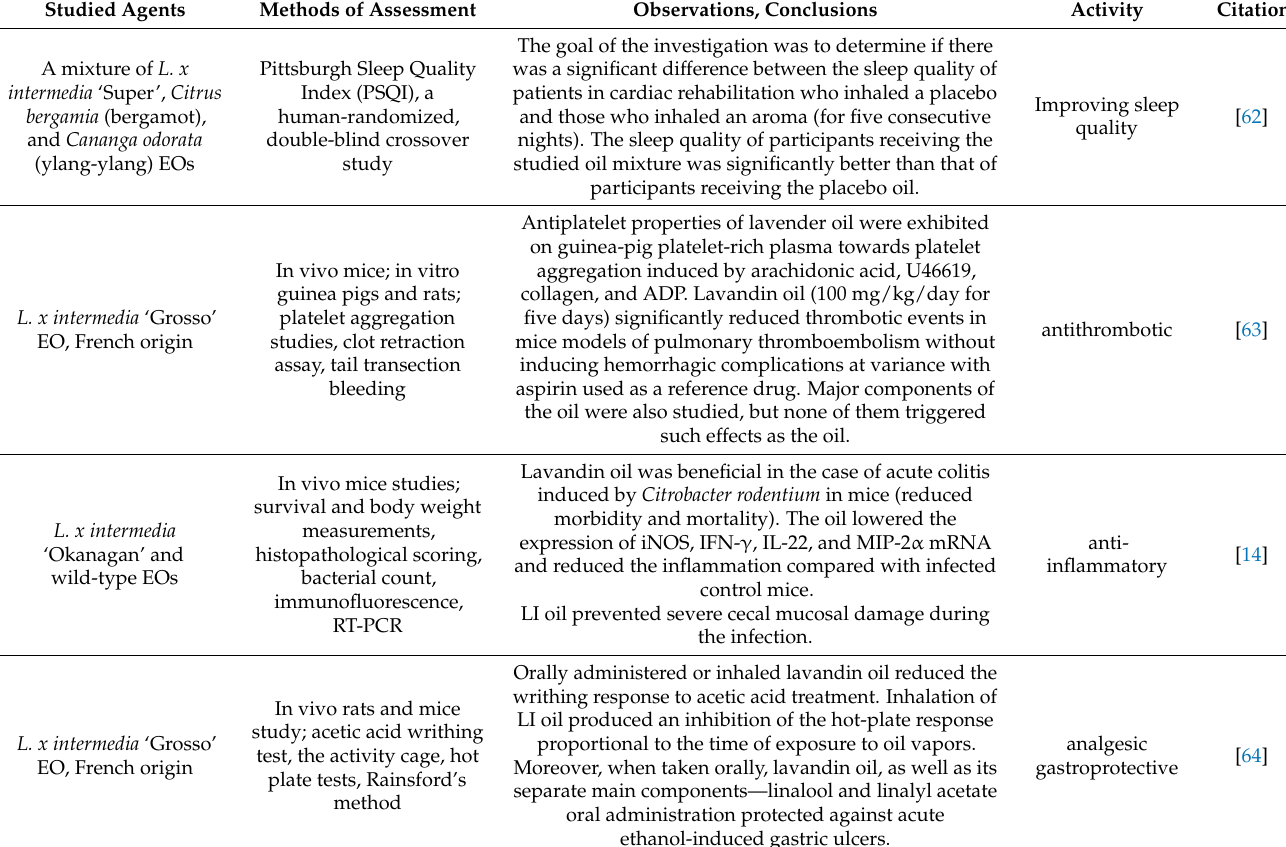
Table 3. Bioactivities of lavandin natural products reported in the literature (other than the biocidal). Only original research articles were